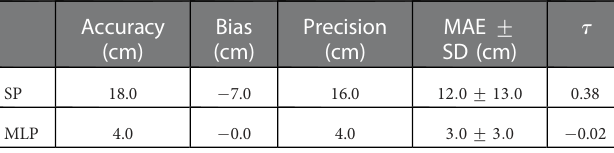
The accuracy is computed as the RMSD of h FP and the estimates of each model; the bias is computed as the average difference of h FP and the estimates of each model; the precision is computed as the standard deviation of the differences between h FP and the estimates of each model; MAE is the mean absolute error ( + standard deviation); t is the Kendall ’ s tau coef fi cient of the averages versus the absolute differences for each model.